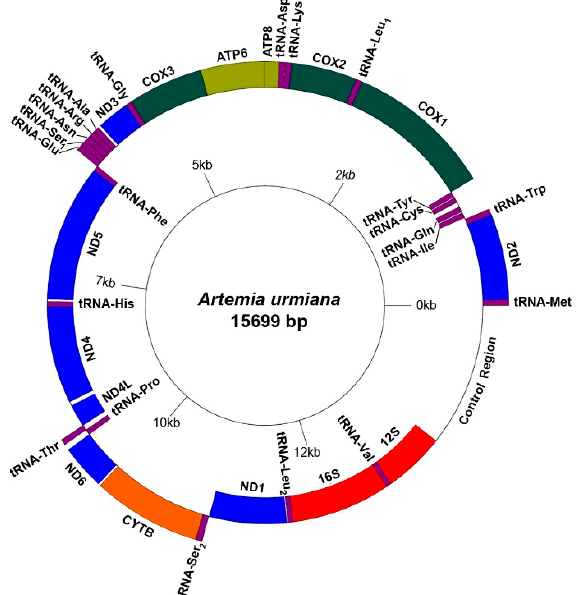
Figure 1. Complete mitochondrial genome map of Artemia urmiana .